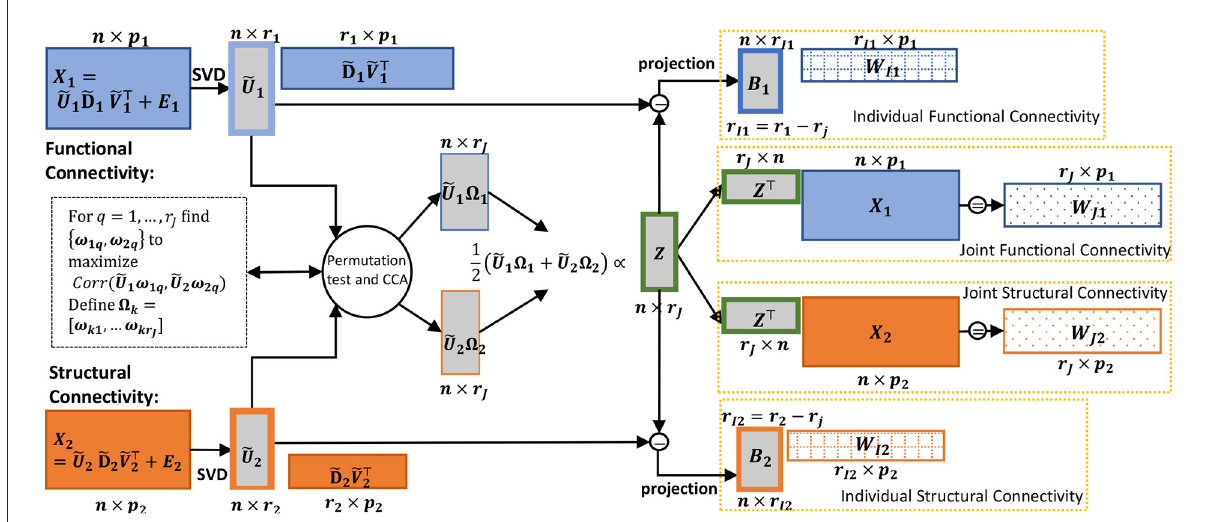
FIGURE1 Schematic of the CJIVE decomposition for obtaining joint subject scores and loadings. Quantities specific to X 1 are shown in blue; those specific to X 2 , orange. Gray boxes illustrate scores, with a green outline for joint scores. Checked and dotted boxes represent loadings. Steps are outlined in Algorithm 1. Separately, SVD is applied to each data block (far left) to obtain low-rank PC scores (all score matrices are shown as gray boxes). Next, CCA is applied to the PC scores with the number of components chosen using a permutation test. Joint subject scores are equivalent to a weighted average of the resultant canonical variables. Joint loadings result from the matrix product between joint subject scores and data blocks, i.e., regression of the data blocks onto joint subject